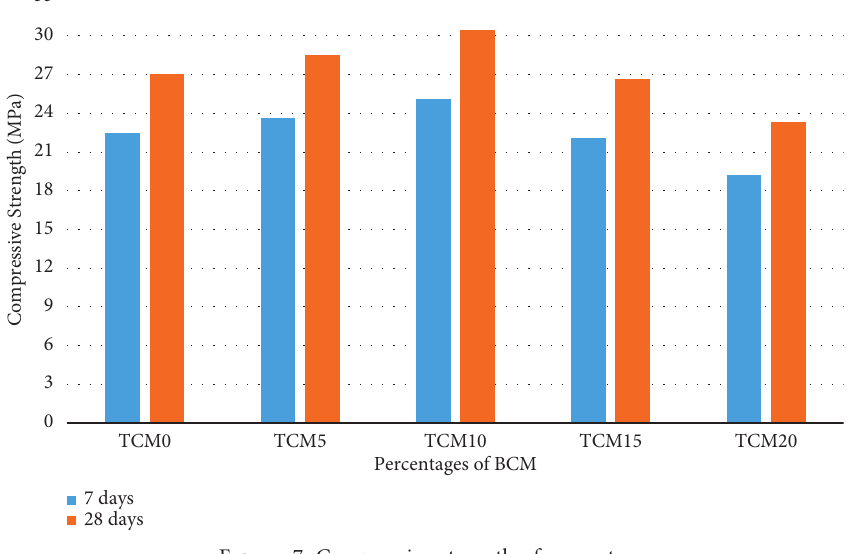
Figure 7: Compressive strength of concrete.